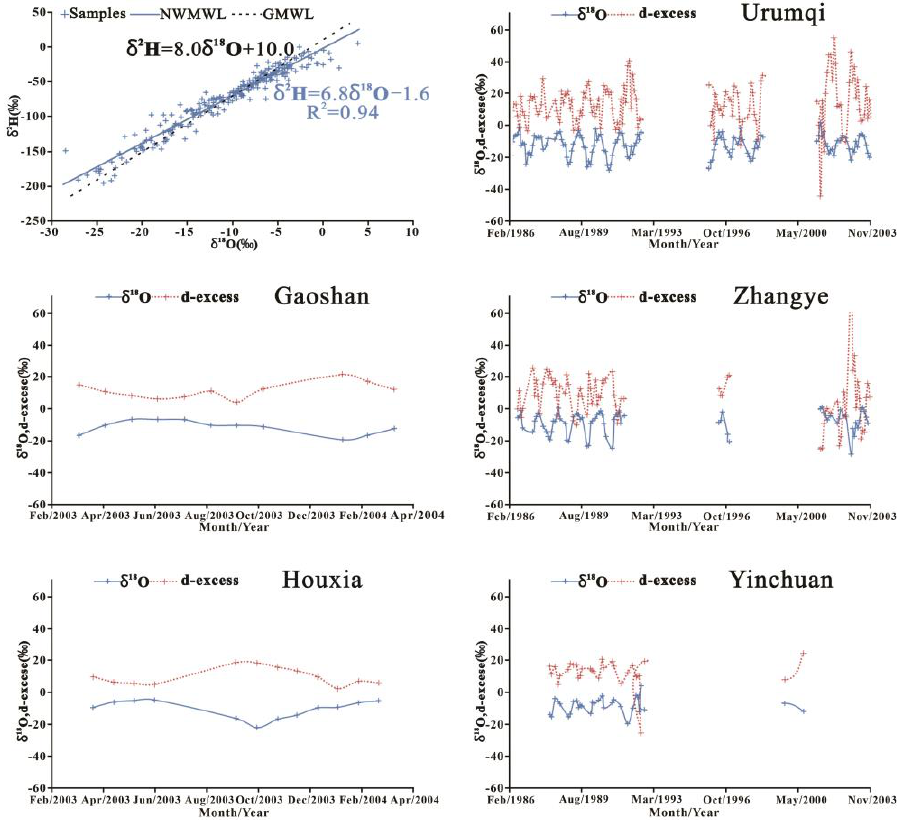
Figure 3. Local meteoric water line calculated for Northwest China from this study ( top left ) and variations of precipitation δ 18 O and d-excess time record for selected stations in Northwest China.